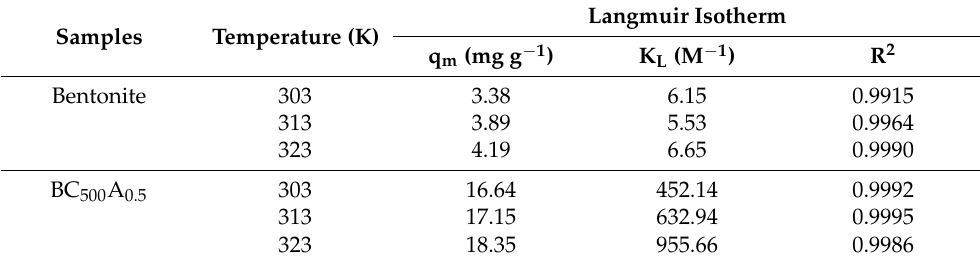
Table 9. Parameters for adsorption of atrazine on bentonite and BC 500 A 0.5